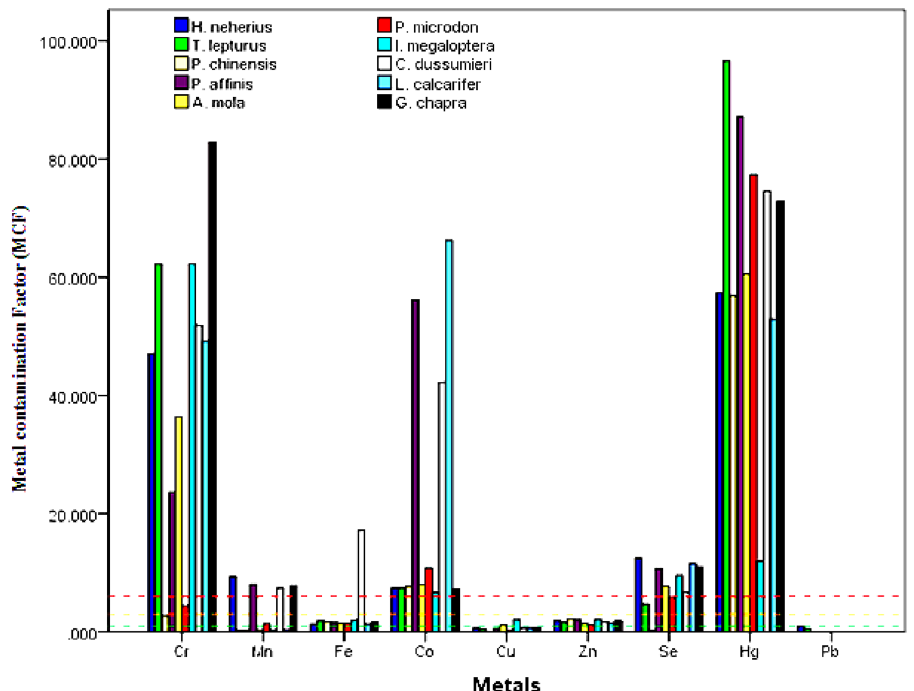
Figure 3. Heavy metal contamination factors in dried fish species. The dashed red lines indicates a very high metal concentration, the dashed orange lines indicates moderate metal concentration while the dashed green lines indicates low metal concentration.